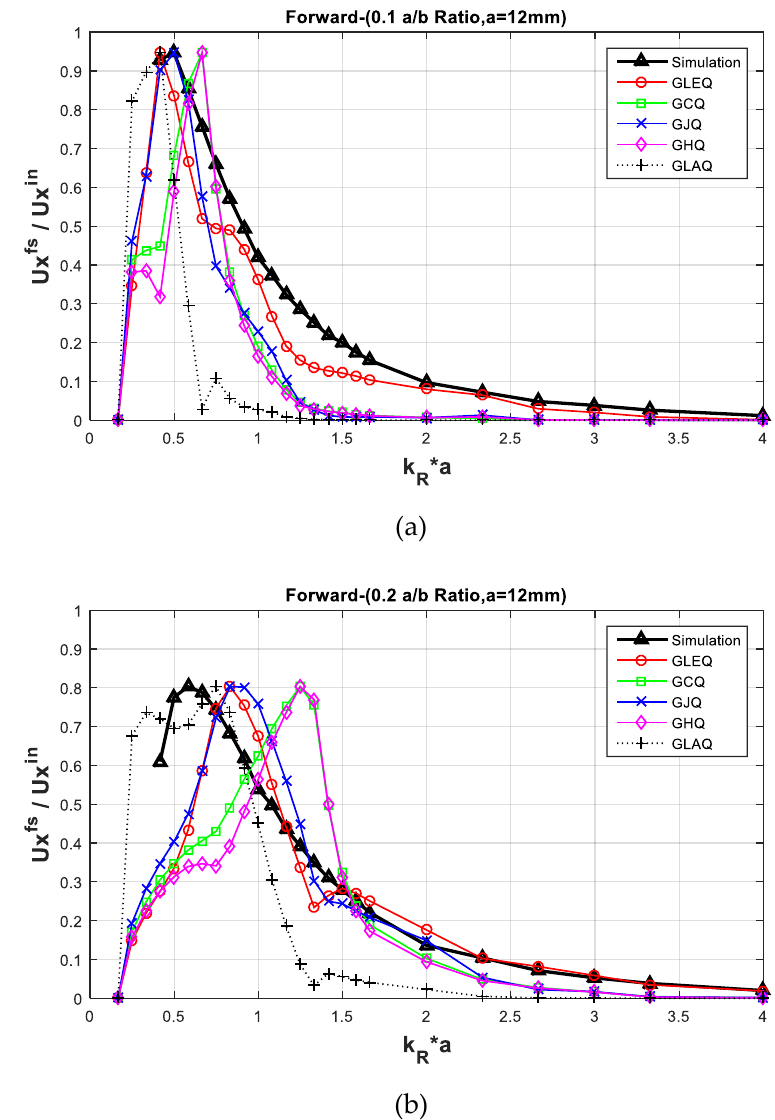
Figure 6. Displacement variation curves of the analytical model and FE simulation by different a/b ratio of the forward scattering models: (a) result from 0.1 𝑎/𝑏 ratio model (C12–0.1), (b) result from 0.2 𝑎/𝑏 ratio model (C12–0.2). The figure implies the longer crack model represents the higher wave scattering energy and narrow distribution curve. The peak displacement variations of the shorter crack model are obtained at the relatively higher k R a